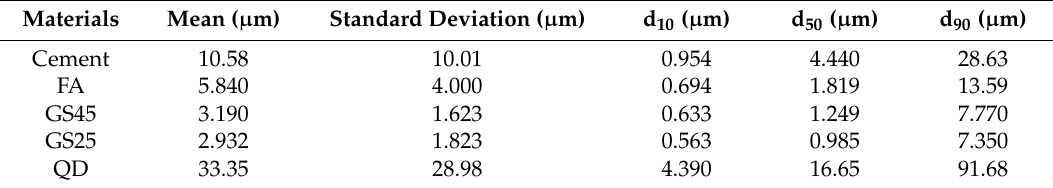
Table 3. Particle size distribution of cement, FA, GS45, GS25 and